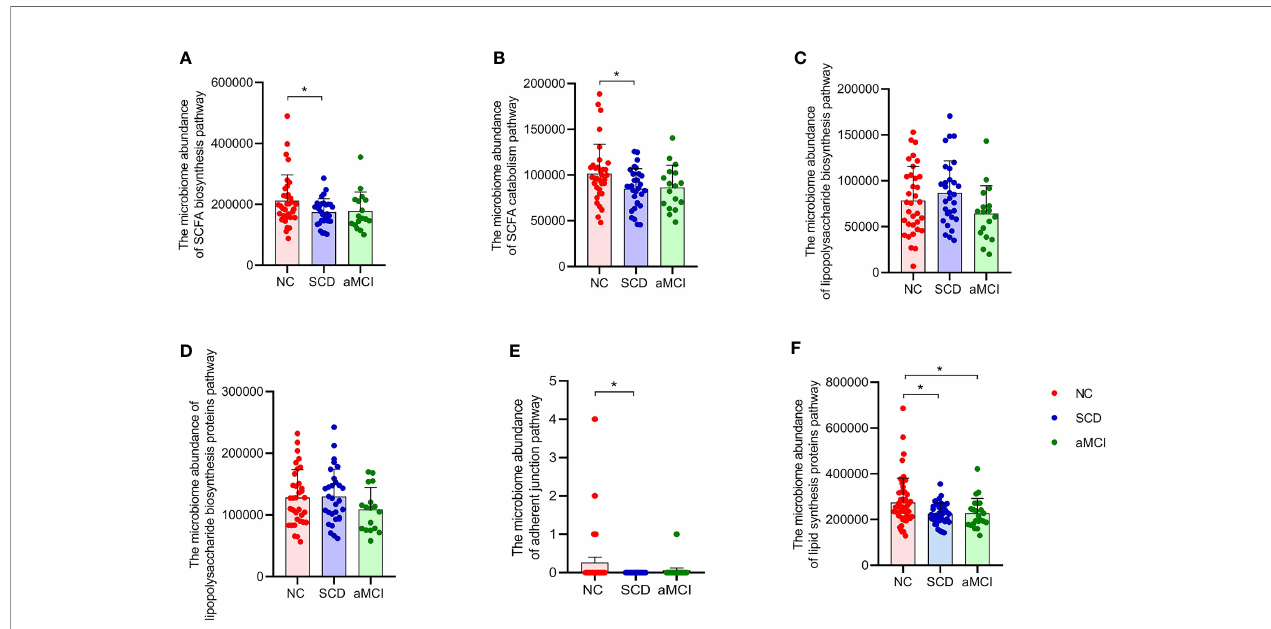
FIGURE 3 | (A – F) Prediction analysis in intestinal fl ora between different cognitive groups. PICRUST compared the KEGG database to get the microbiome abundance of each metabolic pathway at KEGG pathway level 3. The Y axis and the X axis represent the intestinal abundance of each metabolic pathway at KEGG pathway level 3 and groups respectively, and the error bar means the standard deviation. The columns with red, blue, and green colors represent the NC, SCD, and aMCI groups respectively. Wilcoxon rank sum test showed that there were higher abundance of three metabolic pathways in NC group than those in SCD group (*P-value < 0.05, Wilcoxon rank sum test), including short-chain fatty acid biosynthesis (KEGG pathway id: ko00061; (A) and catabolism (KEGG pathway id: ko00071; (B) and adherent junction (KEGG pathway id: ko04520; (E) . There was insigni fi cant difference between three cognitive groups in lipopolysaccharide biosynthesis (KEGG pathway id: ko00540; (C) and lipopolysaccharide biosynthesis proteins (KEGG pathway id: ko00541; (D) (*P-value < 0.05, Wilcoxon rank sum test). And Lipid biosynthesis proteins (KEGG pathway id: ko00537; (F) were lower in SCD and aMCI group compared with NC group (P = 0.018 and 0.027; Wilcoxon rank sum